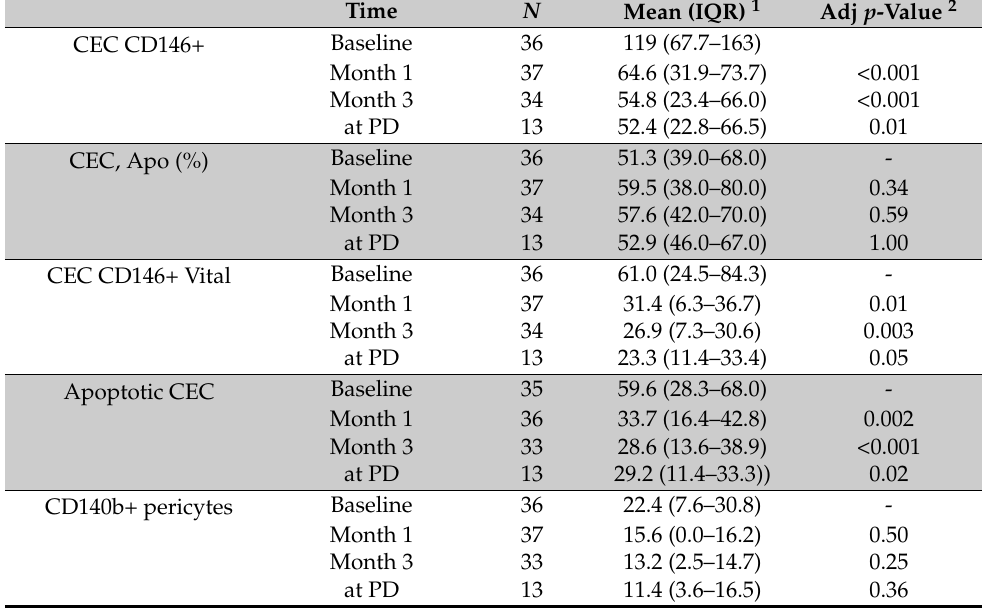
Table 2. Summary Statistics of CCs by time from everolimus start.